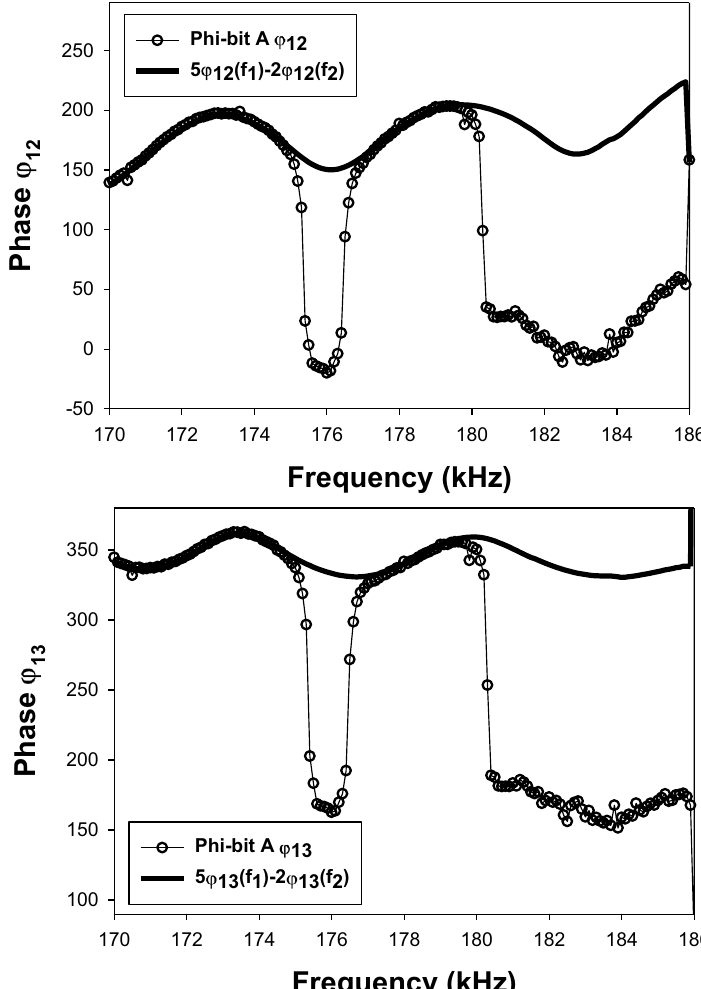
Figure 3. Phases ϕ 12 and ϕ 13 (open circles) measured for the phi-bit “A” defined by the mixed frequency 5 f 1 2 f 2 when f 1 62kHz and the second driving frequency is varied in the interval [70–62 kHz] by − = decreasing increments of 50 Hz. In both graphs the thick solid line corresponds to the linear combination of phases 5 ϕ